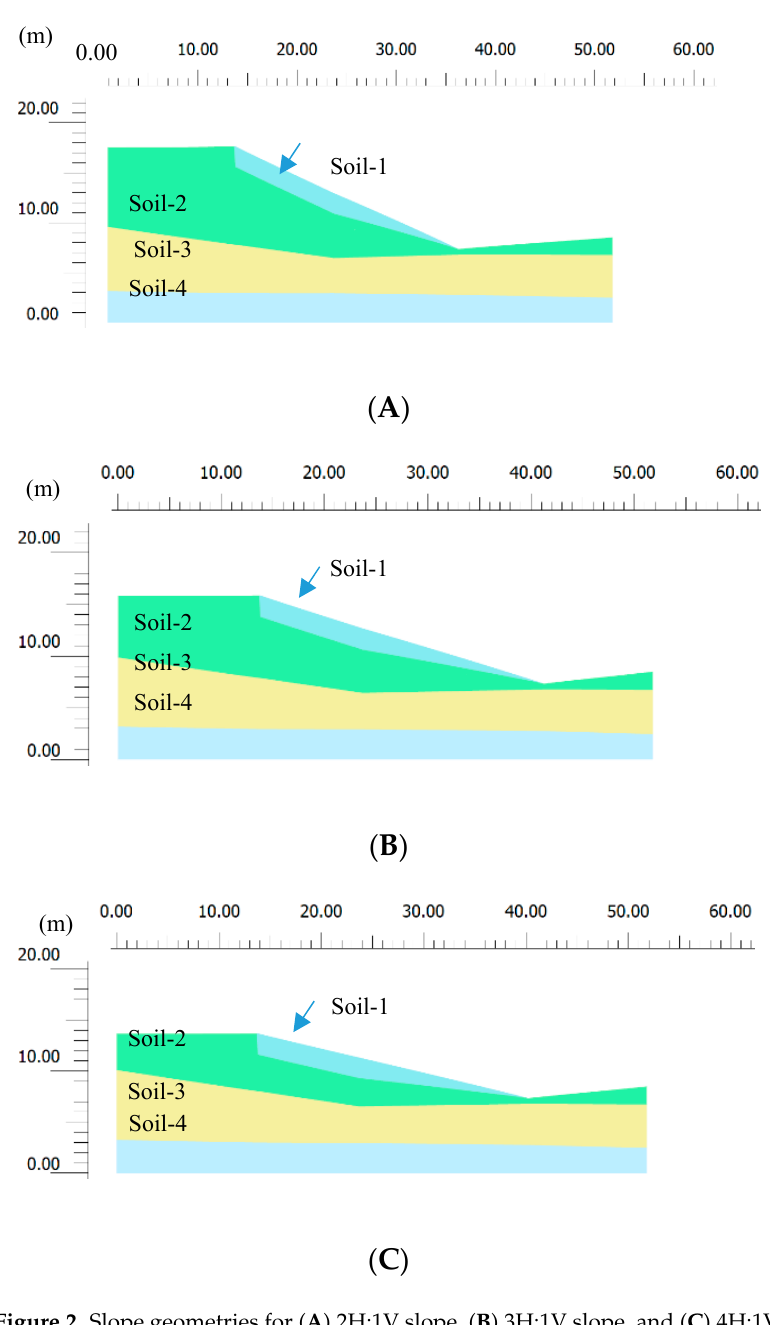
Figure 2. Slope geometries for ( A ) 2H:1V slope, ( B ) 3H:1V slope, and ( C ) 4H:1V slope.